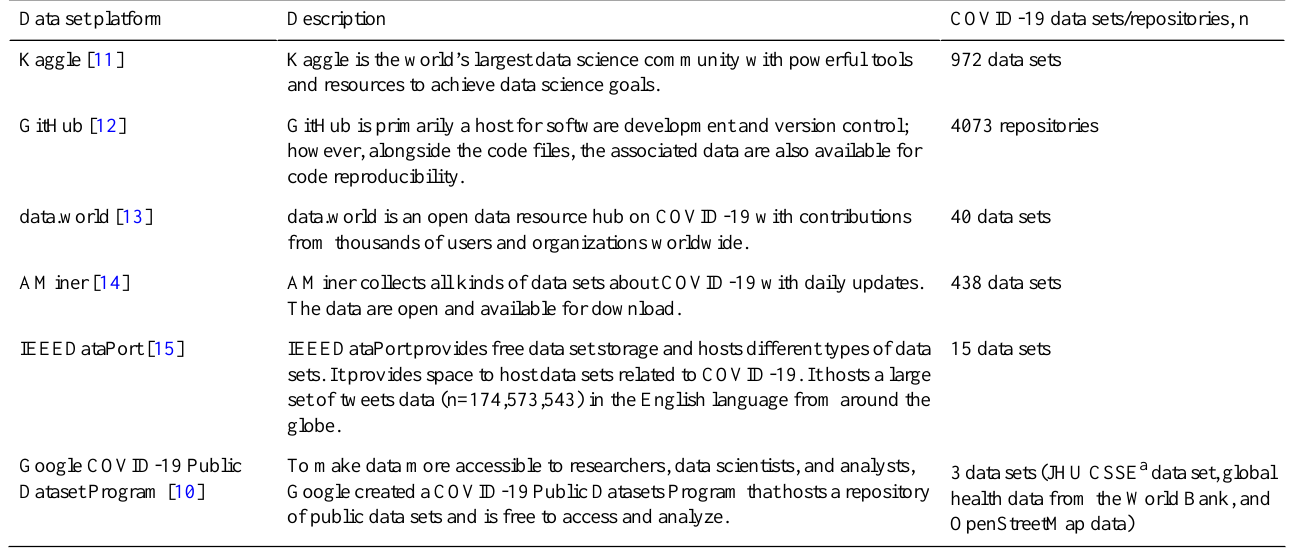
Table 1. A brief description of COVID-19 platforms that offer an open repository of data sets and their scope and usefulness. goals.Kaggle [11] and resources to achieve data science [12] however, alongside the code files, the associated data are also available for code worldwide.data.world [13] from thousands of users and organizations download.AMiner [14] The data are open and available for globe.IEEEDataPort [15] sets. It provides space to host data sets related to COVID-19. It hosts a large set of tweets data (n=174,573,543) in the English language from around the make data more accessible to researchers, data scientists, and analysts, Google created a COVID-19 Public Datasets Program that hosts a repository of public data sets and is free to access